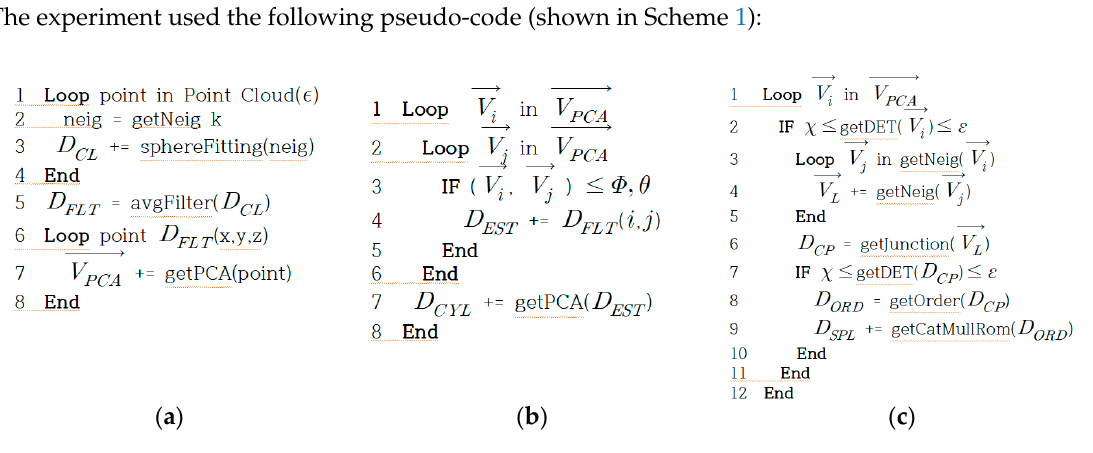
Scheme 1. Pseudo Code for proposed method: ( a ) sphere fitting; ( b ) straight lines estimation; ( c ) curves estimation.